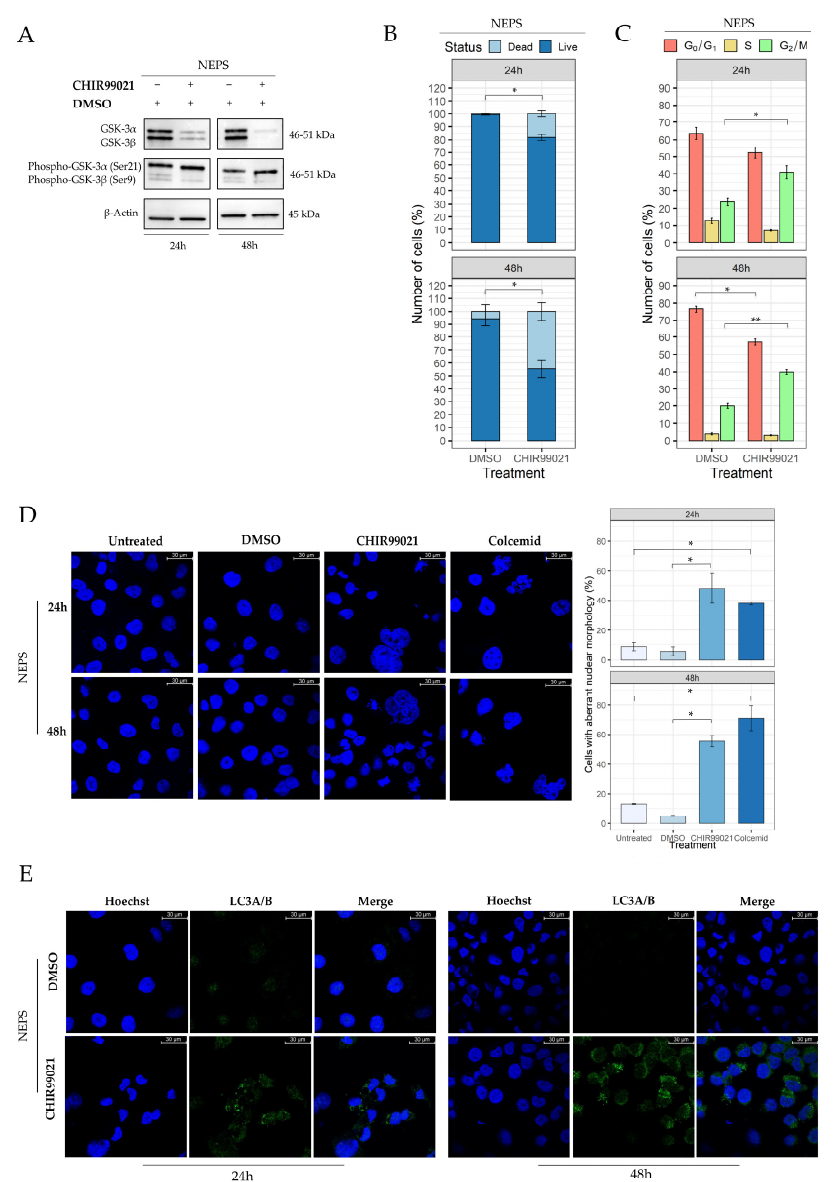
Figure 8. CHIR99021 affects the proliferation of the NEPS cell line. ( A ) Western blot analysis showing the expression of GSK-3 α / β and phospho-GSK-3 α / β proteins in NEPS cells after treatment with CHIR99021 or vehicle for 24 and 48 h. The same blot was reprobed with anti- β -Actin to confirm the equal loading of each lane (40 µ g of whole lysate). ( B ) CHIR99021 effect on the viability of the NEPS cell line, evaluated using a trypan blue exclusion assay. Cells were exposed to 50 µ M for 24 and 48 h. Cell viability is presented as percentages distinguishing dead cells (light blue) from live cells (blue). The graph represents means ± SE of three independent experiments; differences between treatments groups were estimated by paired t tests. ( C ) Distribution of cell cycle phases of NEPS cell treated with CHIR99021 50 µ M for 24 and 48 h. Histogram represents the percentage of cell number in the G 0 /G 1 , S, and G 2 /M phases after treatment. The values are representative of means ± SE of three separate experiments using paired t test (*: p < 0.05; **: p < 0.001). ( D ) CHIR99021 induces mitotic catastrophe in the NEPS cell line. Cells were treated with CHIR99021 50 µ M for 24 or 48 h, stained with Hoechst-33342, and examined with fluorescence microscopy at 63X magnification. The aberrant morphology of cells was based on the evaluation of at least 30 nuclei in each sample. Each bar is the mean ± S.E. value from three separate experiments; (* p < 0.05, ** p < 0.001 versus the relative controls. ( E ) Cells were treated with CHIR99021 50 µ M for 24 or 48 h and LC3A/B-fluorescent puncta were